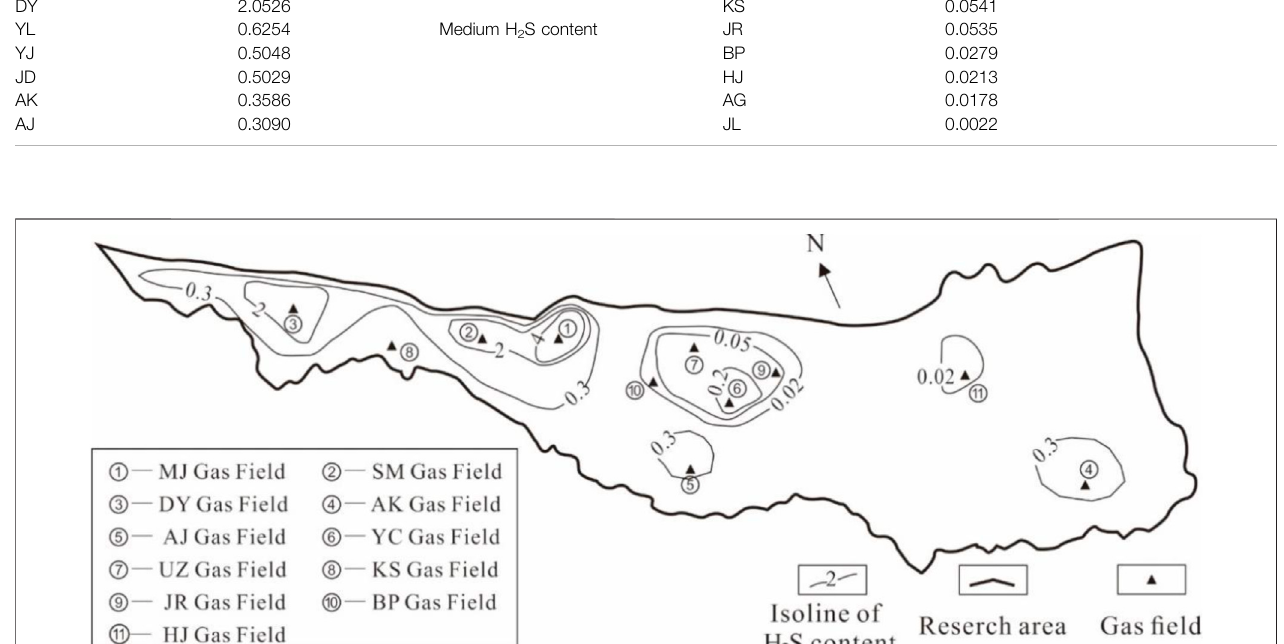
FIGURE 3 | H 2 S distribution map of gas fi elds in the Right Bank of the Amu Darya.